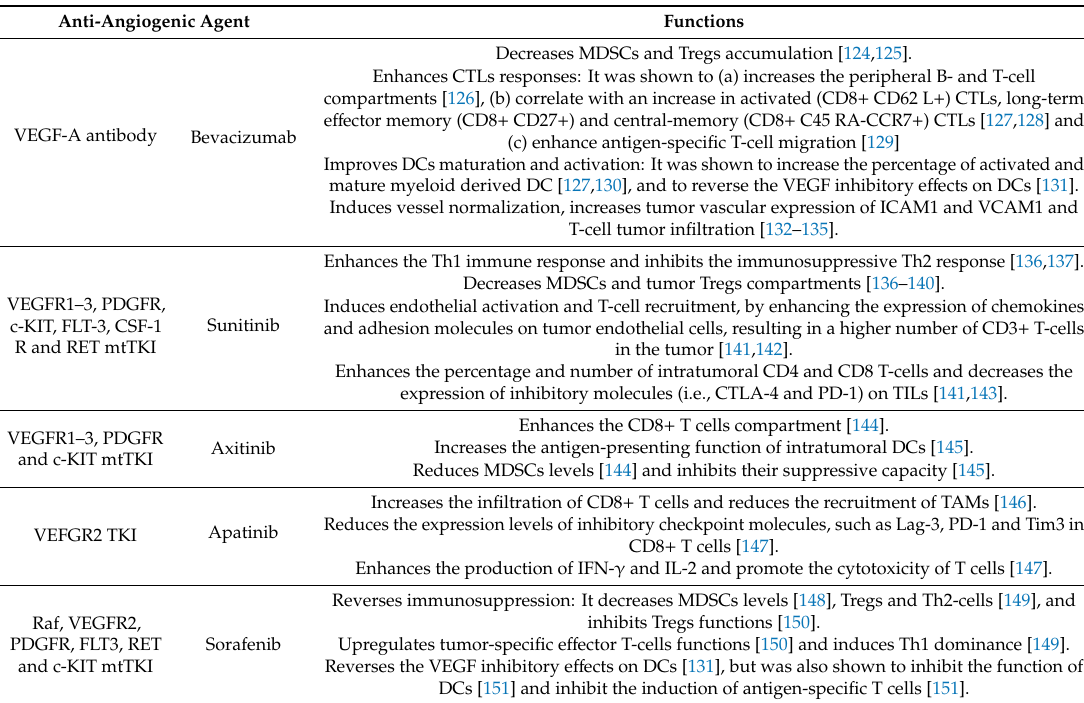
Table 2. Immunomodulatory e ff ects of selected anti-angiogenic